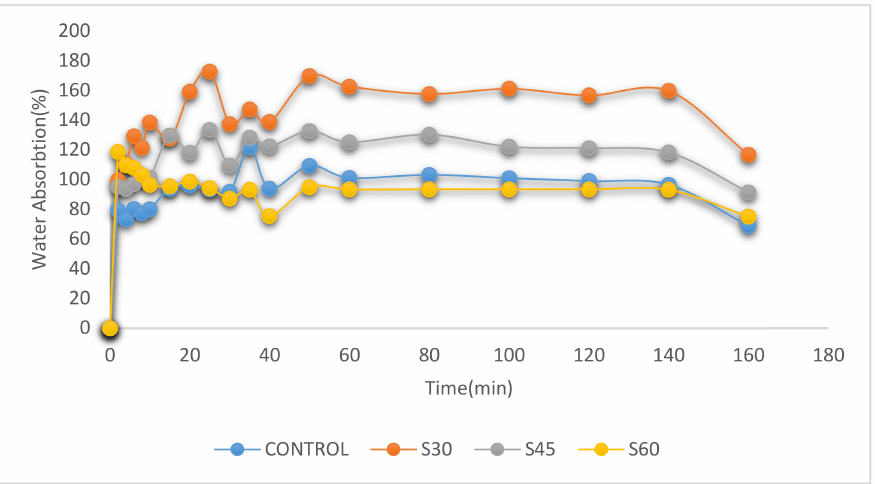
Figure 4. Water absorption on CS films with sorbitol